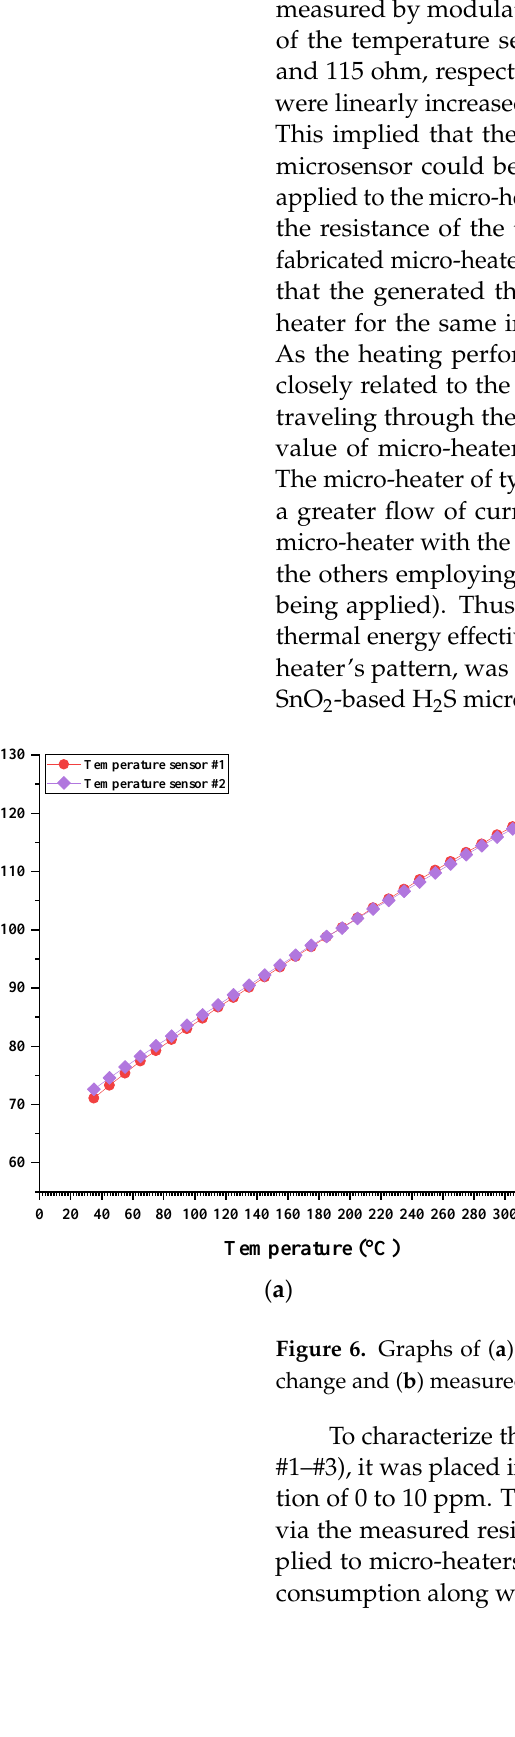
Figure 5. XRD patterns as a function of SnO 2 depositing time.